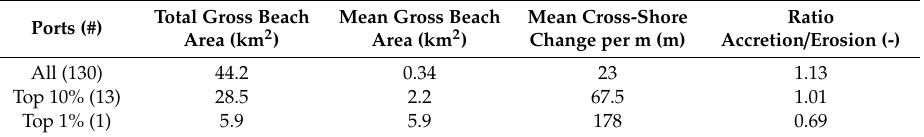
Table 3. Overview of the results for all 130 ports, the top 10% and the top 1% in terms of total gross beach area changes. For all these categories the total and mean gross beach area changes are provided as well as the mean cross-shore changes and the accretion-erosion ratios.